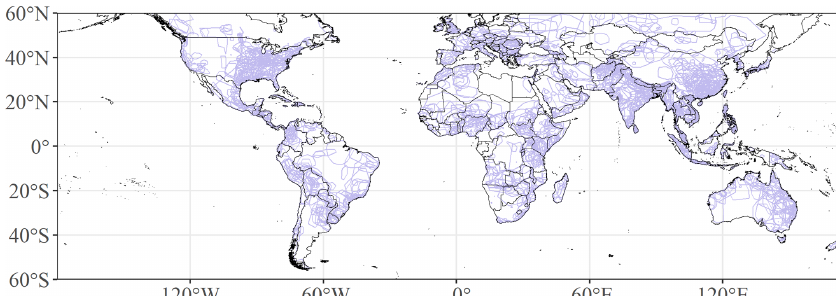
Figure 8. Spatial distribution of DFO-recorded flood events.